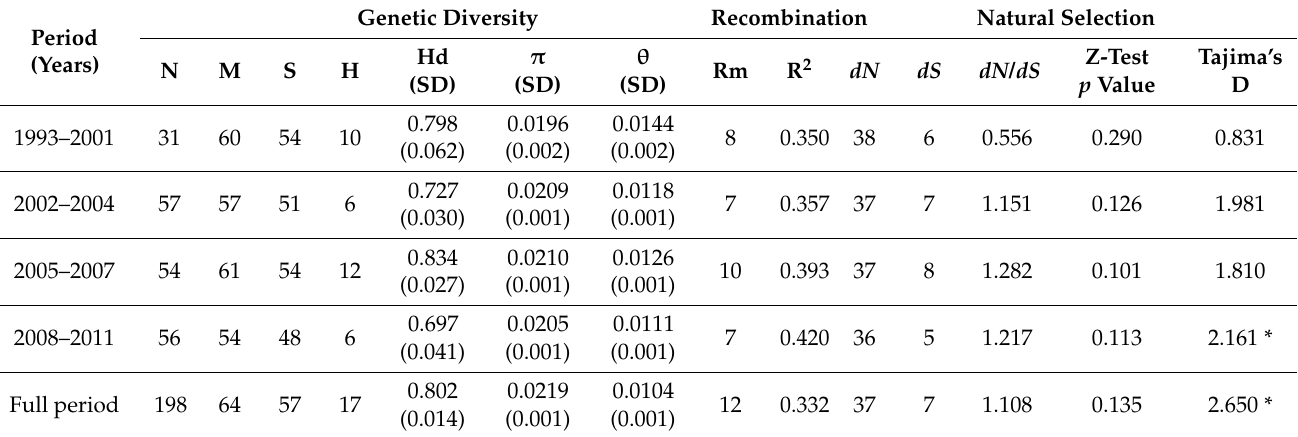
Table 1. Genetic parameters of P. vivax msp1 42 from southern Mexico, analyzed by time-periods.